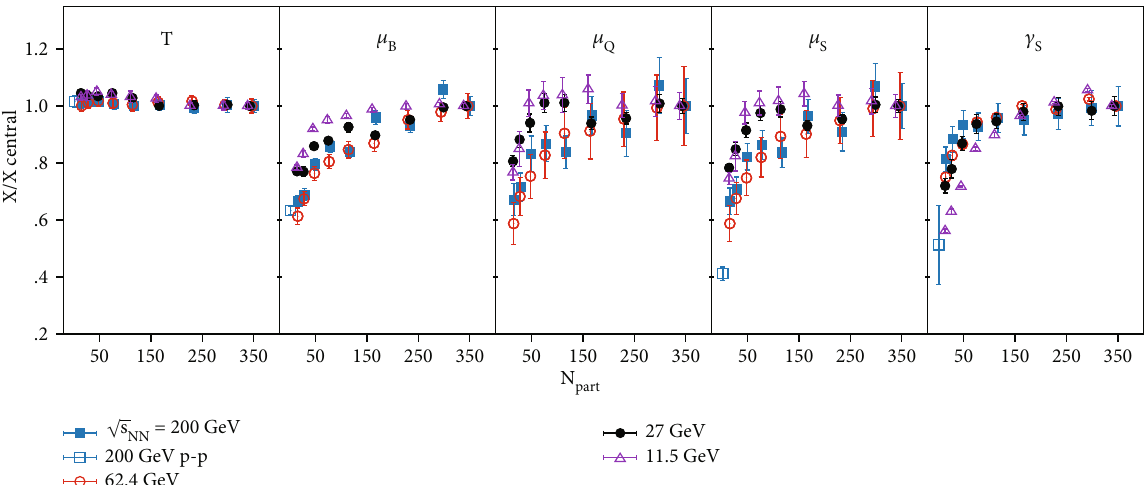
Figure 4: (Color online) scaling behavior of various parameters with N part . Representative points are for collision energies RHIC (200GeV, 62.4GeV) and RHIC-BES (27 GeV, 11.5GeV). Di ff erent columns denote di ff erent scaled